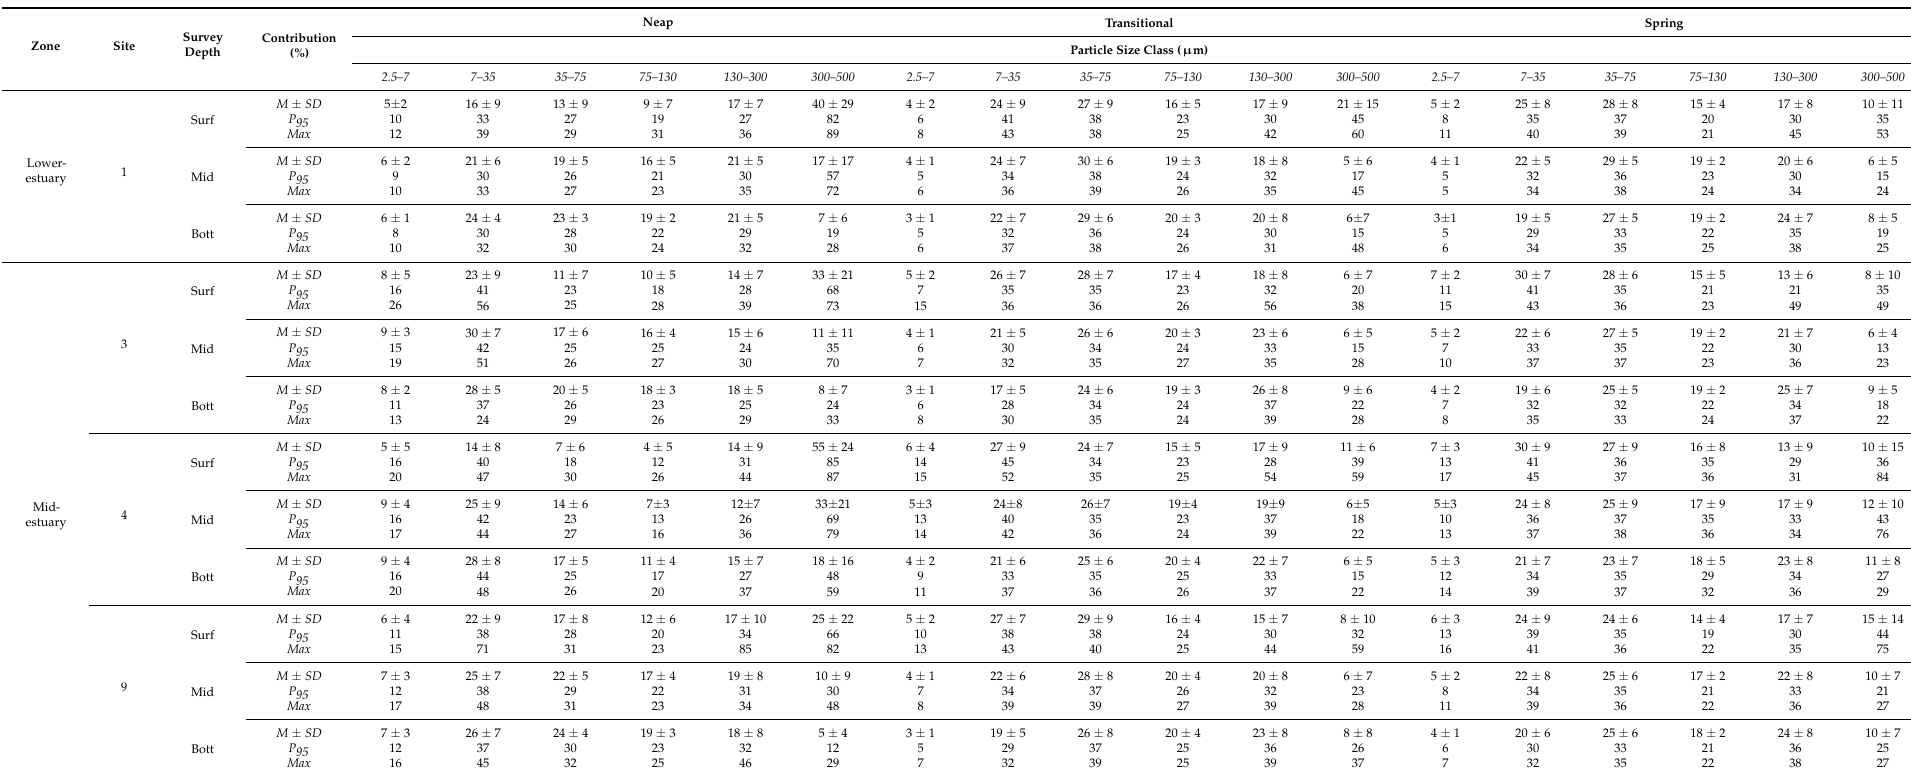
Table A1. Depth compartment-averaged mean ( M ) ± standard deviation ( SD ), 95th percentile ( P 95 ), and maximum ( Max ) particle size class contribution during neap, transitional, and spring tide conditions within the surface (Surf), mid, and bottom (Bott) depth